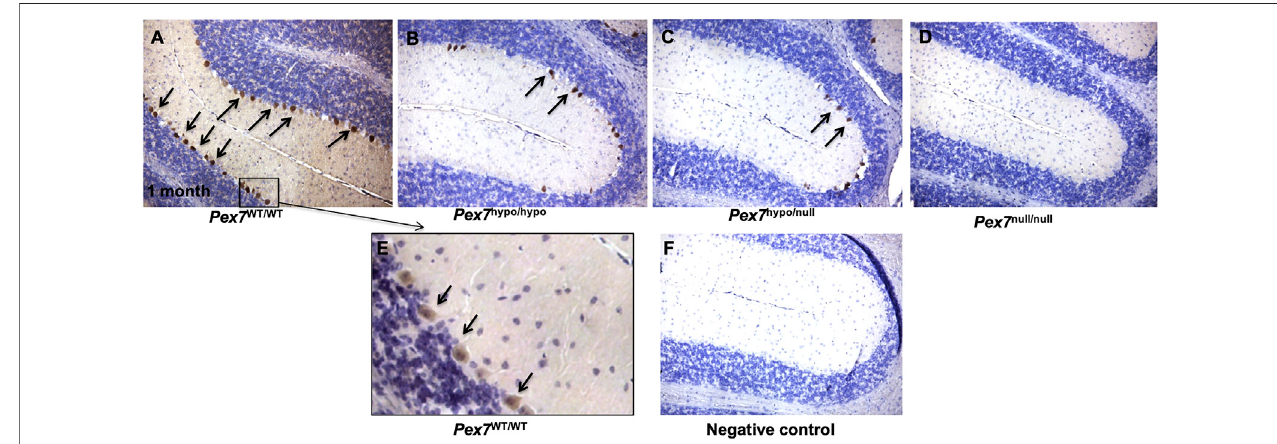
FIGURE 2 | PEX7 protein expression in cerebellar tissues from 1 month old Pex7 de fi cient mice. A highly concentrated PEX7 expression was observed in the cerebellar Purkinje cells of Pex7 WT/WT ( (A, E) higher magni fi cation). However, the cerebellar Purkinje cell sections from Pex7 hypo/hypo Pex7 hypo/null (B, C) display a reductioninPEX7expression.PEX7expressionwasentirelyabsentinthecerebellarPurkinjecellsof Pex7 null/null (D) .Negativecontrolincludes Pex7 WT/WT sectionwithout primaryPEX7antibody (F) .Slideswerecounterstainedwithhematoxylin(Scalebar=100 μ m),( n =3pergenotype).Sectionsfromthesamemiceat1monthofage were stained with anti-Calbindin to determine cerebellar Purkinje cells number (see Figure 8 ).